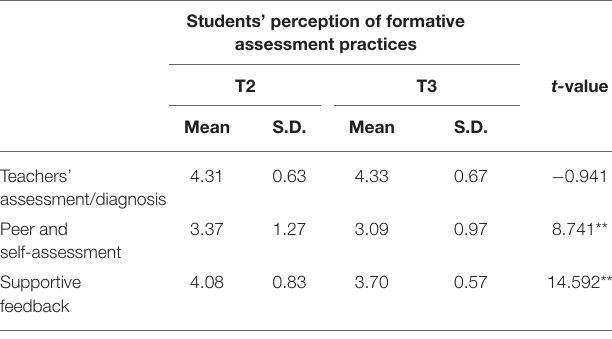
TABLE 4 | Change in students’ perceptions of formative assessment between the end of the project (T2) and 5 months later (T3). Students’ perception of formative assessment